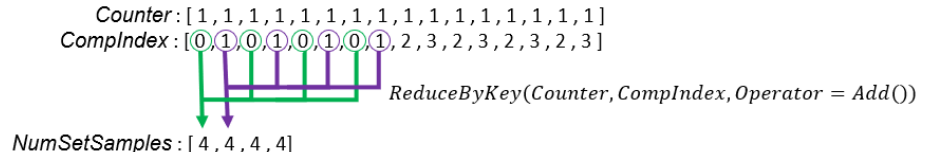
Figure 6. The generation process of NumSetSamples